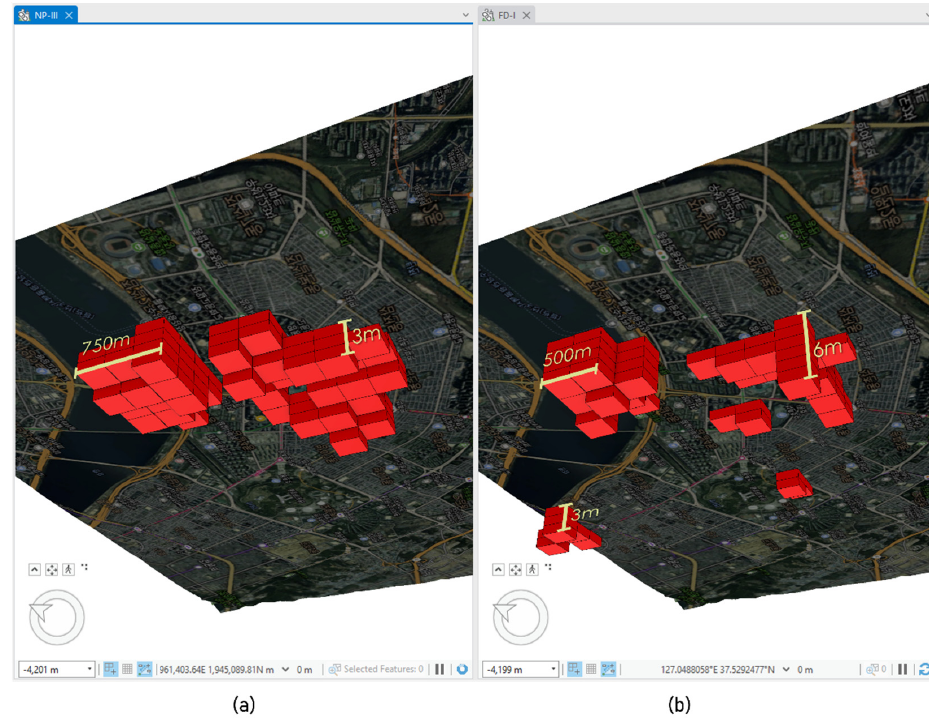
Figure 11. Comparison of IDW interpolation results: ( a ) NP − Ⅲ ; ( b ) FD − Ⅰ .